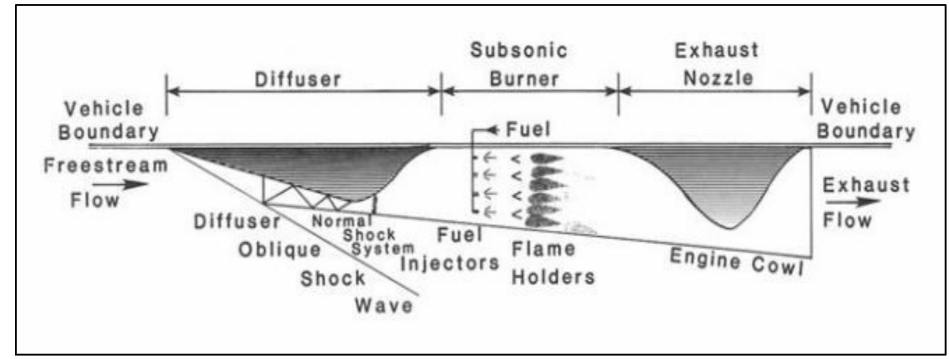
Figure 1. Ramjet engine schematic.